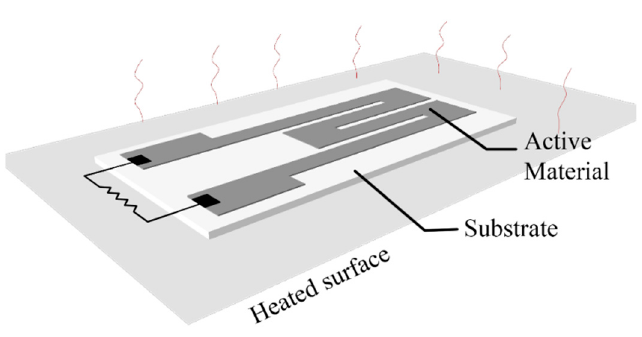
Figure 14. A typical setup for a printed temperature sensor evaluation.